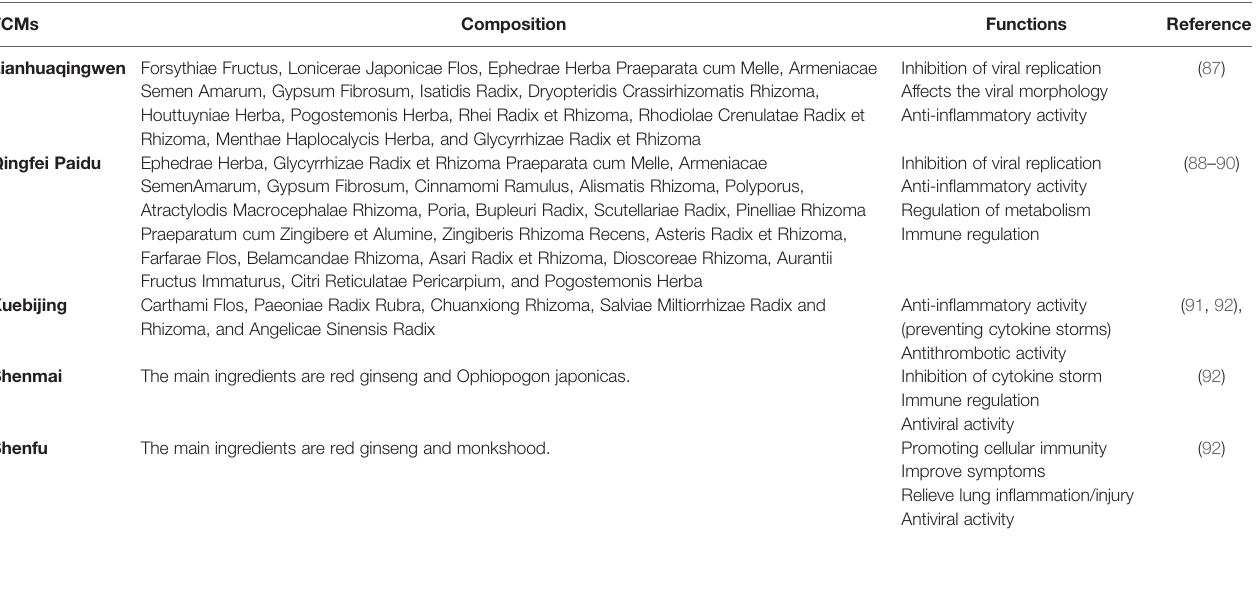
TABLE 1 | The components and ef fi cacy of TCMs used in the treatment of COVID-19.